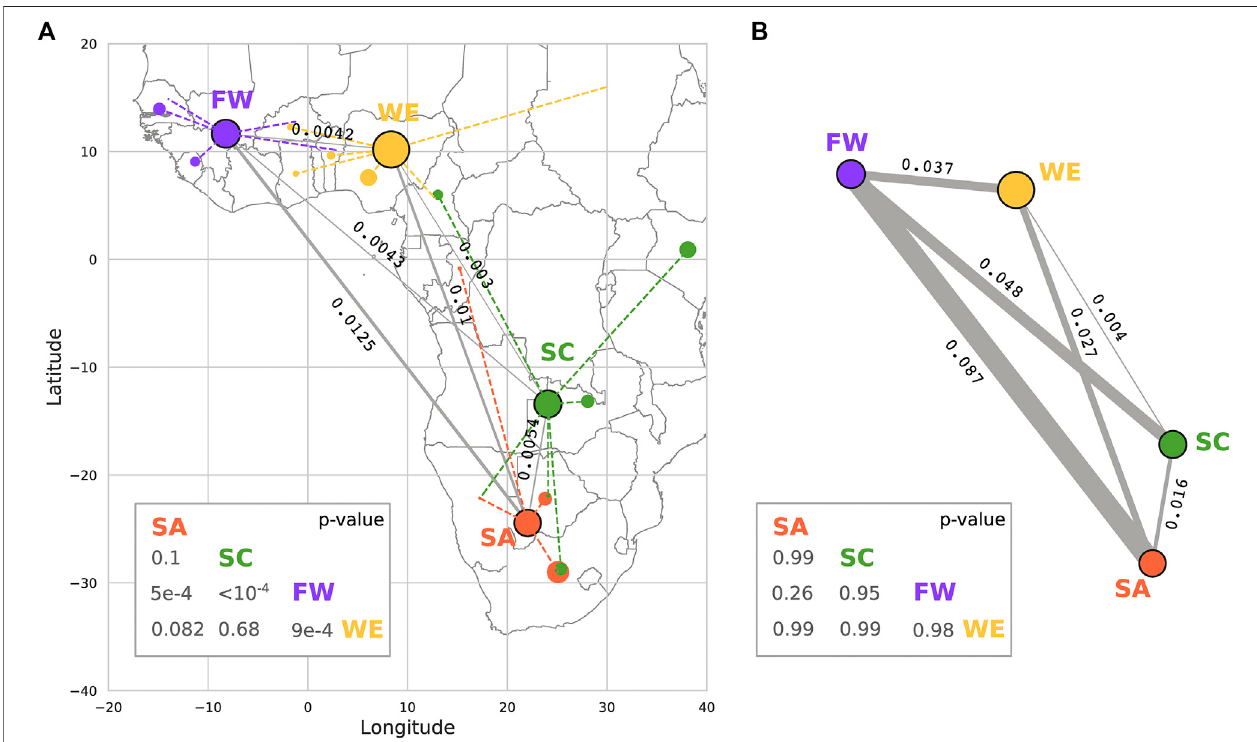
FIGURE 7 | Calculation of Fixation index ( F ST ) between the population clusters. We used HI-vars (A) and all ADME variants (B) to compute the weighted F ST value between each pair of populations using PLINK (version v1.90b6.3). Population clusters are represented by the geographical centroid of the ensemble of country centroidsconstitutingeachcluster.Dashedlineslinkthecentroidsofthecountriestotheclustercentroid.Noderadiiareproportionaltothesizeofeachsample. p -values were calculated from a random F ST distribution by sampling 917 and 32,0983 variants of a random set of genes ( n (cid:1) 2,000) for high impact variants and all ADME variants respectively.